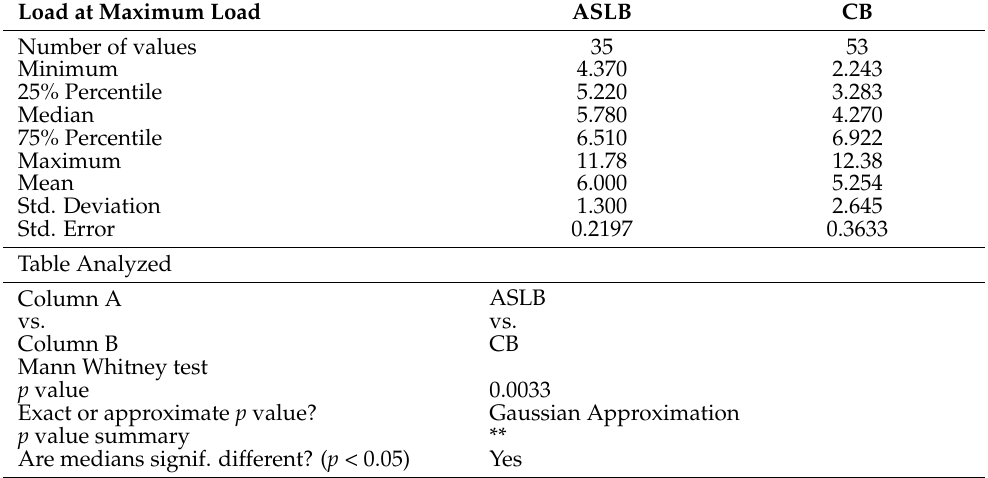
Table A6. Load at maximum load: active self-ligating vs. conventional brackets. Load at Maximum Load